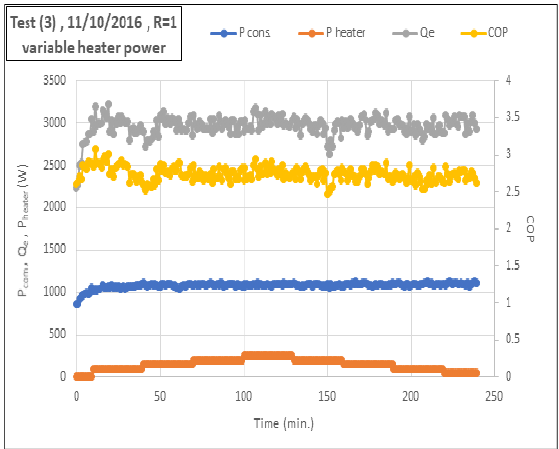
Fig. 11c. Refrigerant pressure and volumetric flow rate with time for test 3.